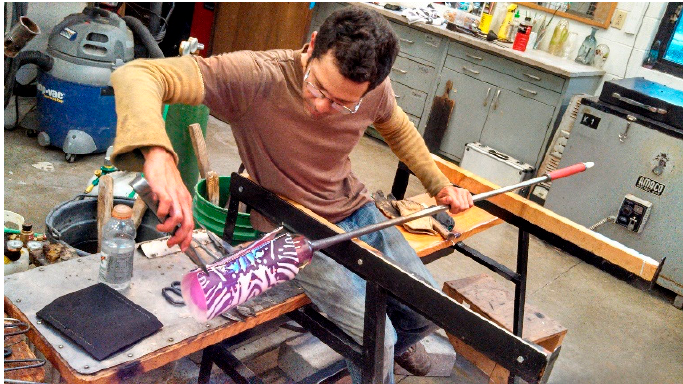
Figure 7. Seaming up the edges of the fused pattern around a bubble. [Created by author].